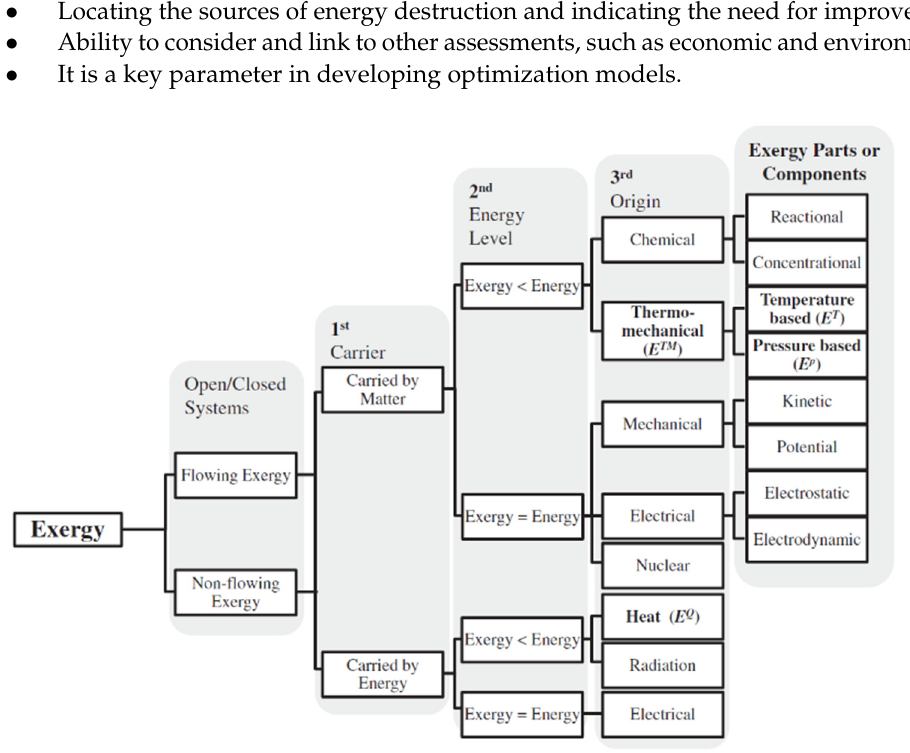
Figure 4. Classification exergy based on its source of generation [51].